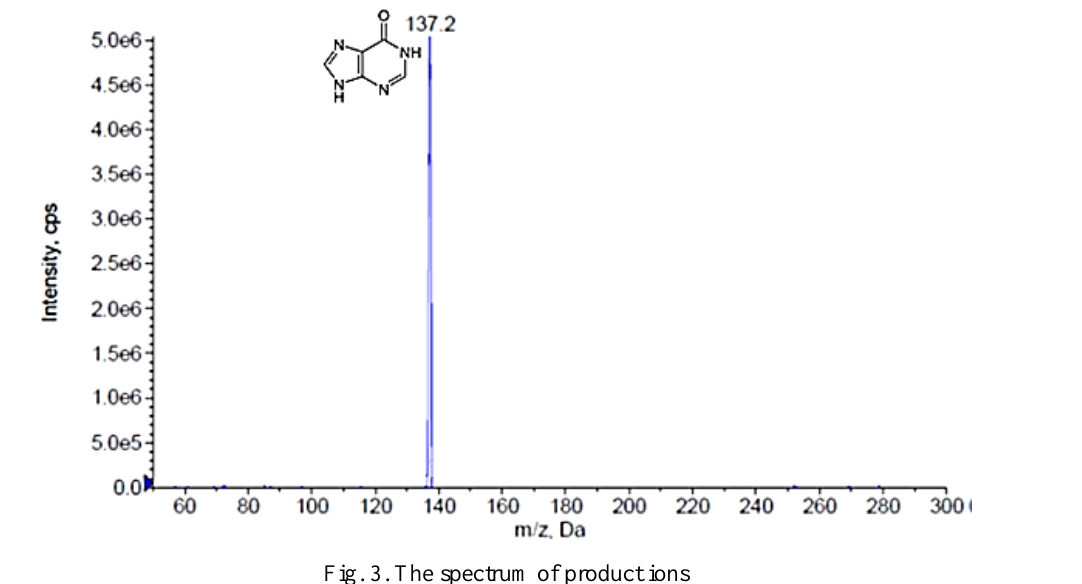
Fig. 3. The spectrum of product ions